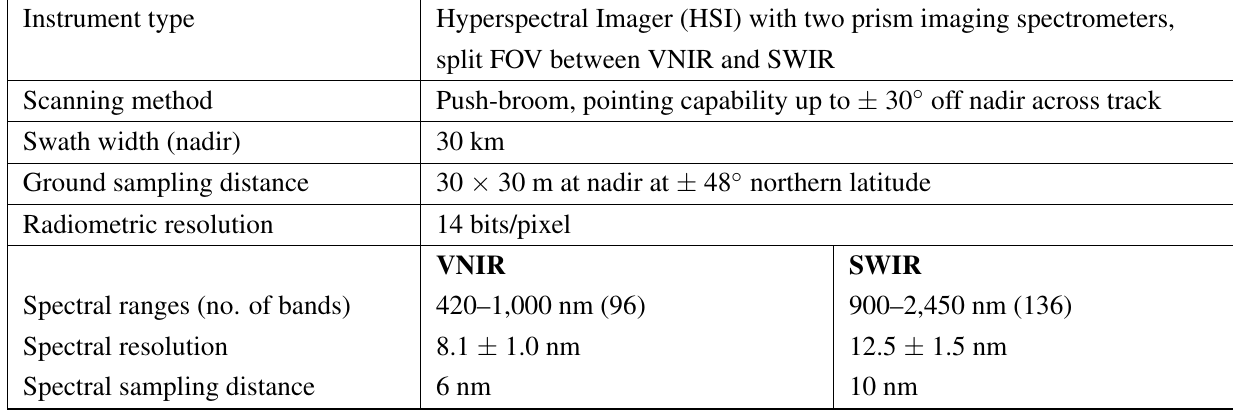
Table 2. EnMAP HSI Instrument parameters